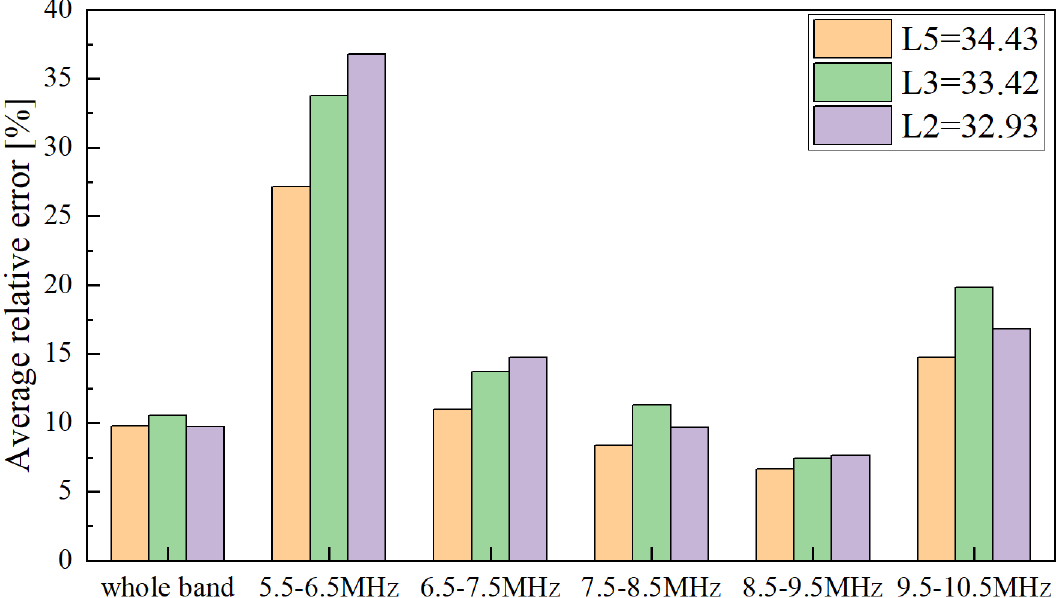
Figure 11. Average relative errors of three different clamping lengths.